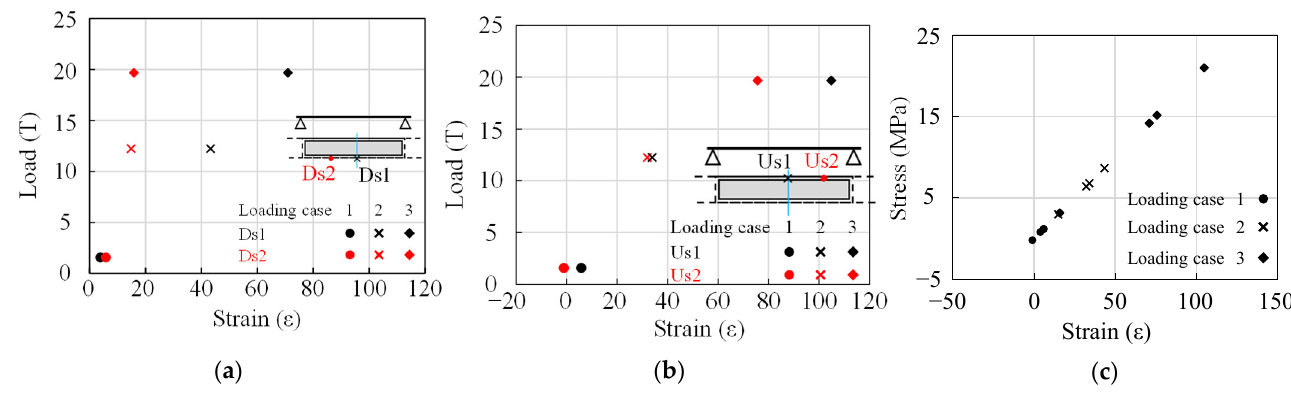
Figure 8. Load vs. strain relationship at ( a ) Downstream. ( b ) Up-stream. ( c ) Stress vs. strain relation- ship.